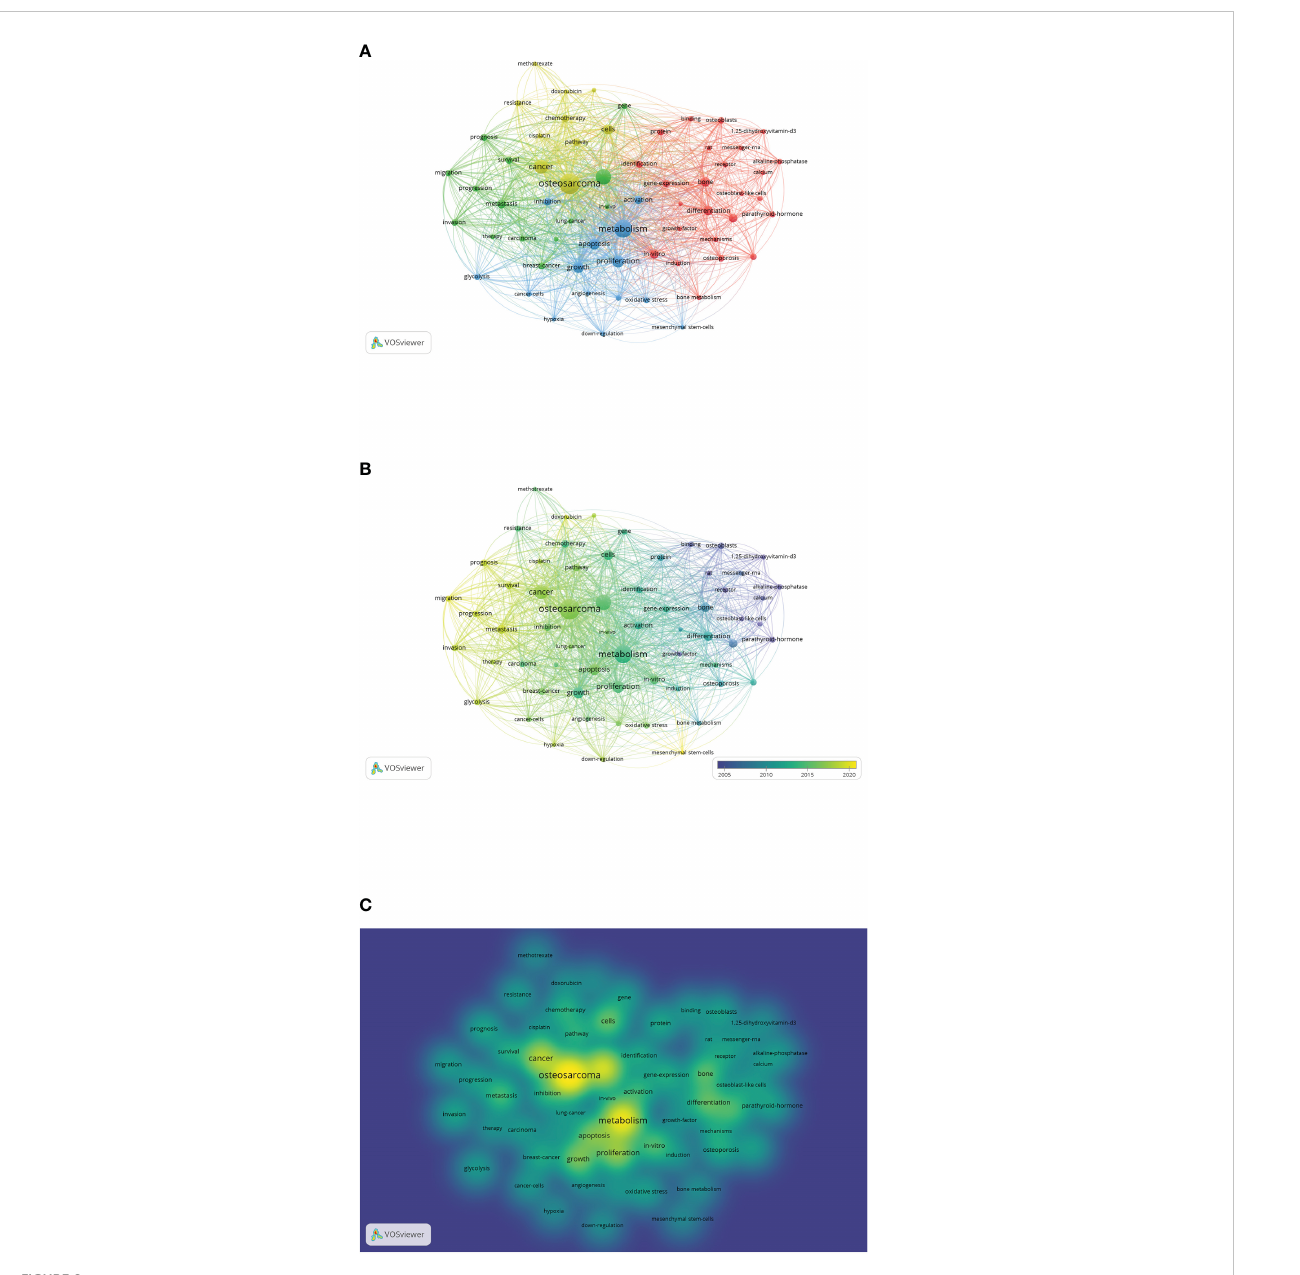
FIGURE 9 Collaborative network diagram of keywords in the fi eld of osteosarcoma metabolism research. (A-C) are the connection network among keywords, the graph of keywords ’ hotness over time, and the graph of keywords ’ density,